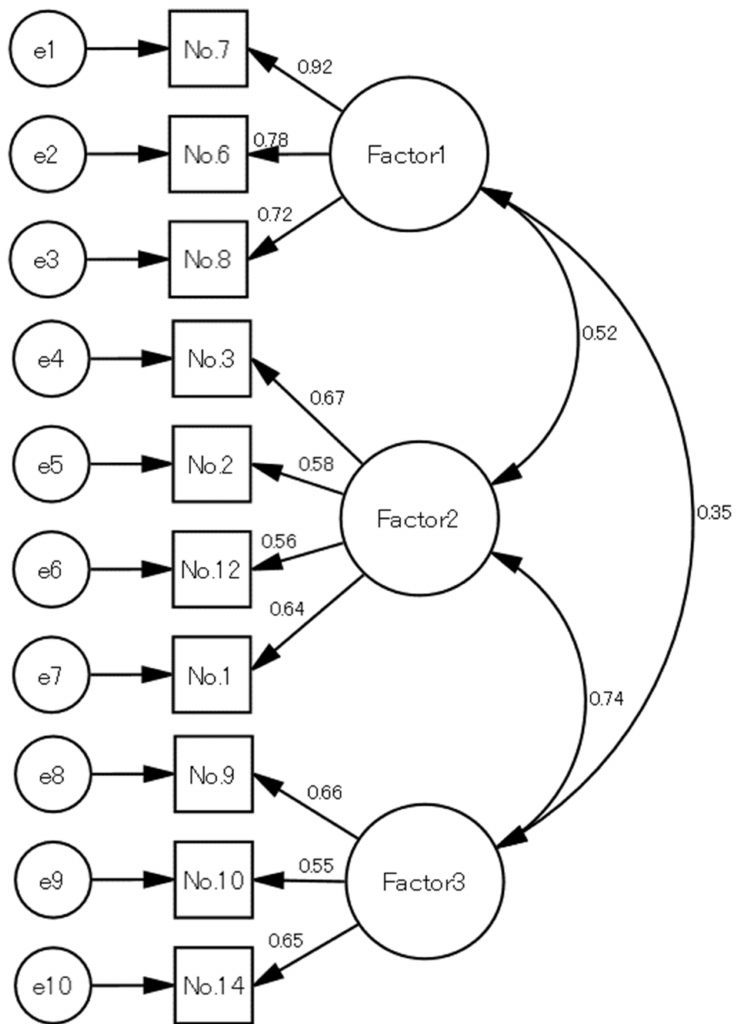
Figure 1. Confirmatory factor analysis of the awareness of long-term care socialization. Numeric val- ues were standardized estimates: goodness-of-fit: χ 2 / df ratio = 1.973, goodness-of-fit index = 0.908, adjusted goodness-of-fit index = 0.871, comparative fit index = 0.918, and root-mean-square error of approximation = 0.081. No. = the number of each item, e = error correlation for each item, Factor 1 = care burden when caring for family, Factor 2 = sense of responsibility to care for family as a member of the family, and Factor 3 = feelings about leaving family care to society. The circles represent the latent variables, and the boxes represent each observed variable. Values in the middle of the two arrowhead lines represent the correlation between the factors. Values in the arrows that point from the factors to the observed values represent the loadings of each of the observed values in the corresponding factor. The values above each observed variable represent the variance explained by the